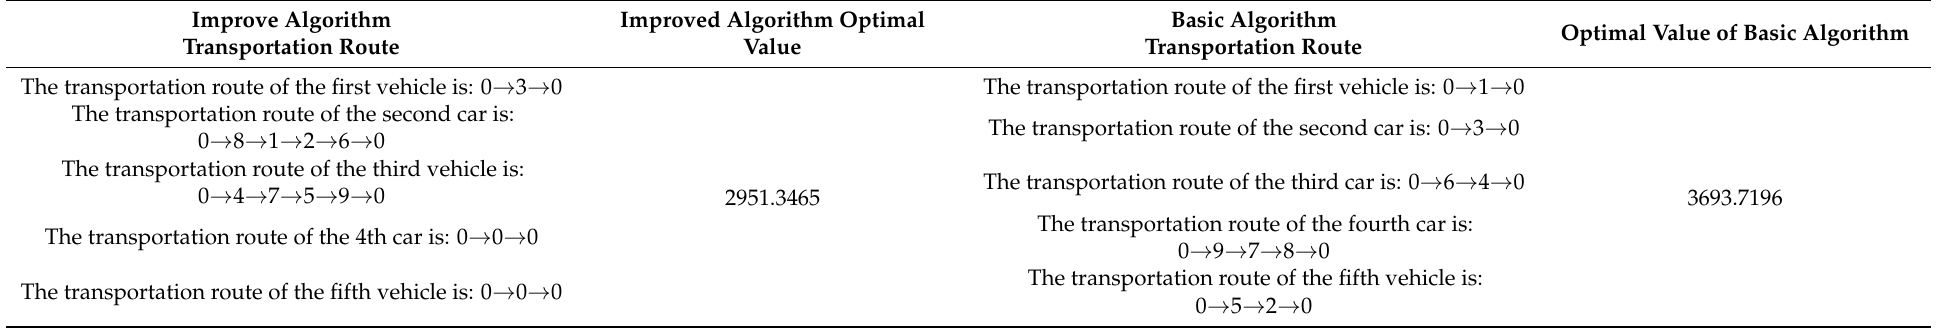
Table 10. Optimization results of emergency logistics vehicle routing considering the urgency of